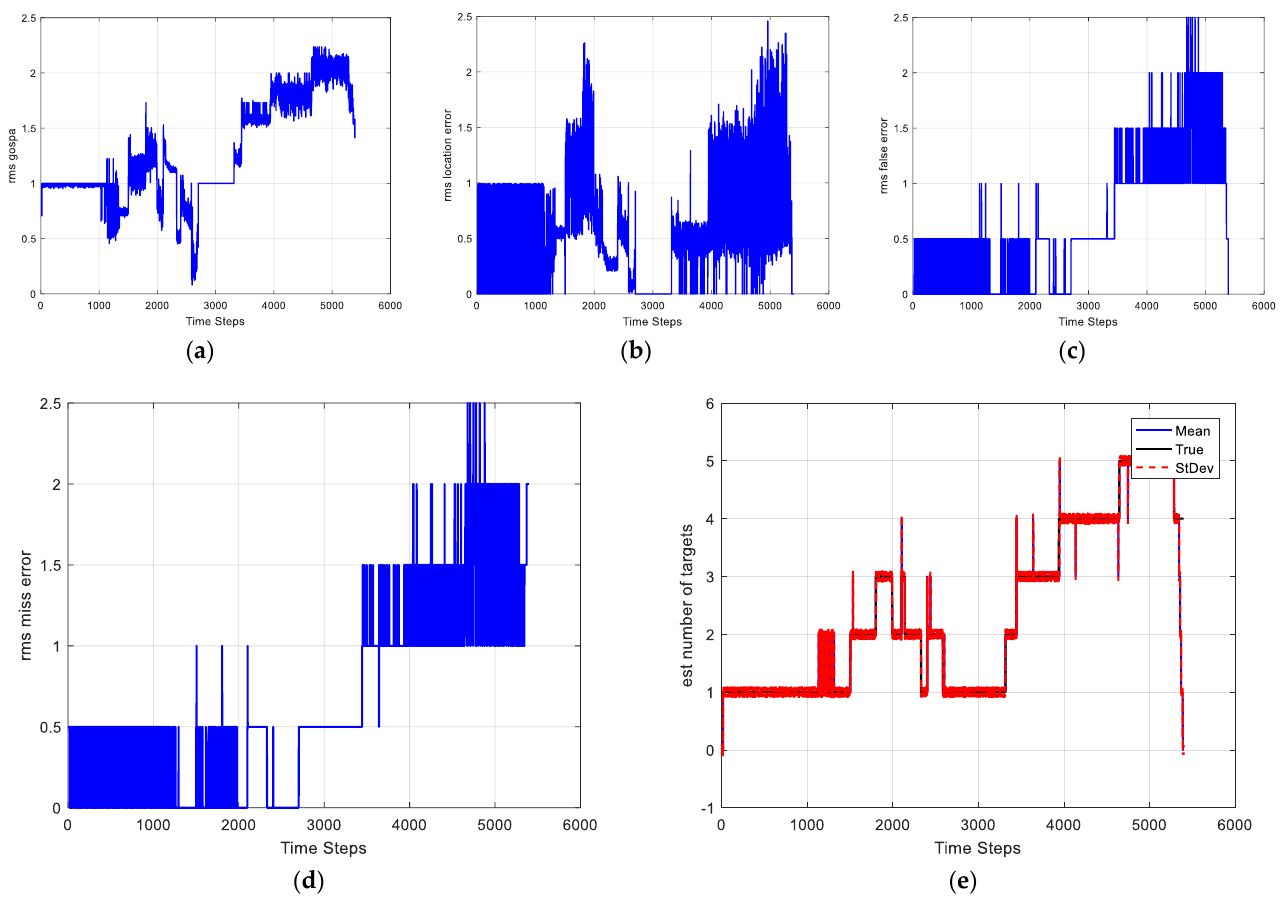
Figure 12. The average GOSPA, LE, FE, ME, and the estimate number of targets of the infrared image ( a ) GOSPA error, ( b ) Location error, ( c ) False error, ( d ) Miss error, ( e ) the number of targets.